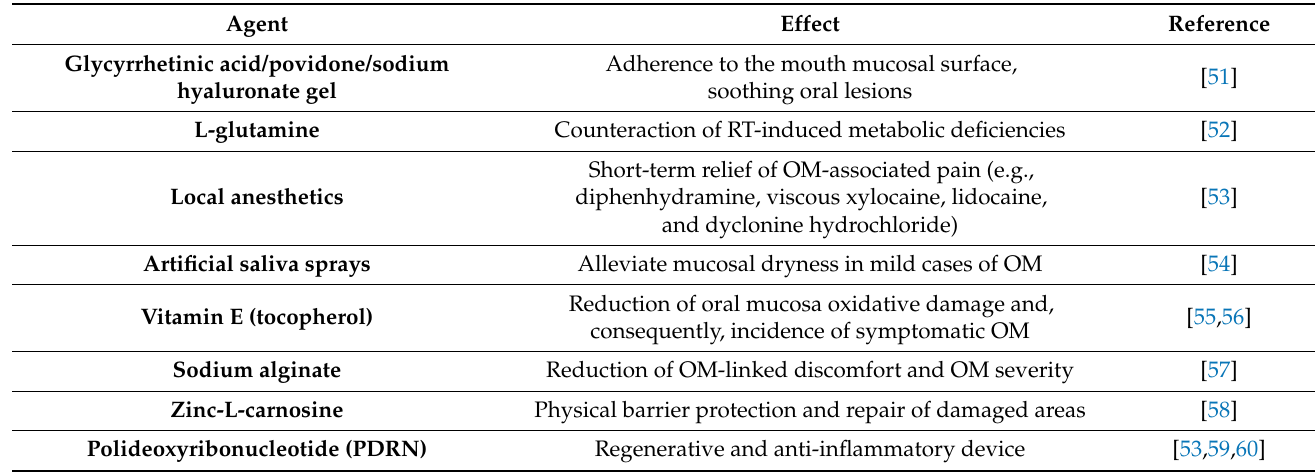
Table 1. Locally applied agents for the treatment of OM listed from most to less commonly used. Agent